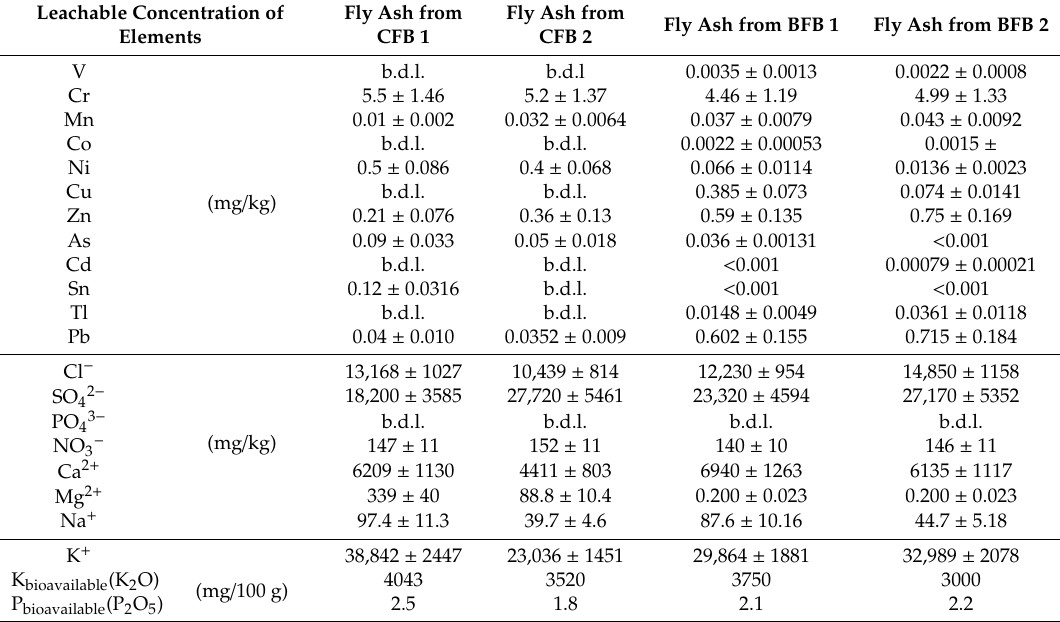
Table 3. Leachability of the elements from biomass